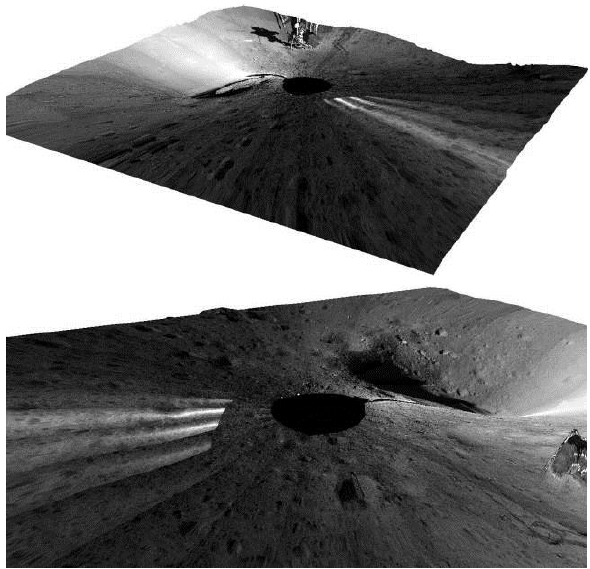
Figure 12. Perspective views of the Pancam DOM draped on the